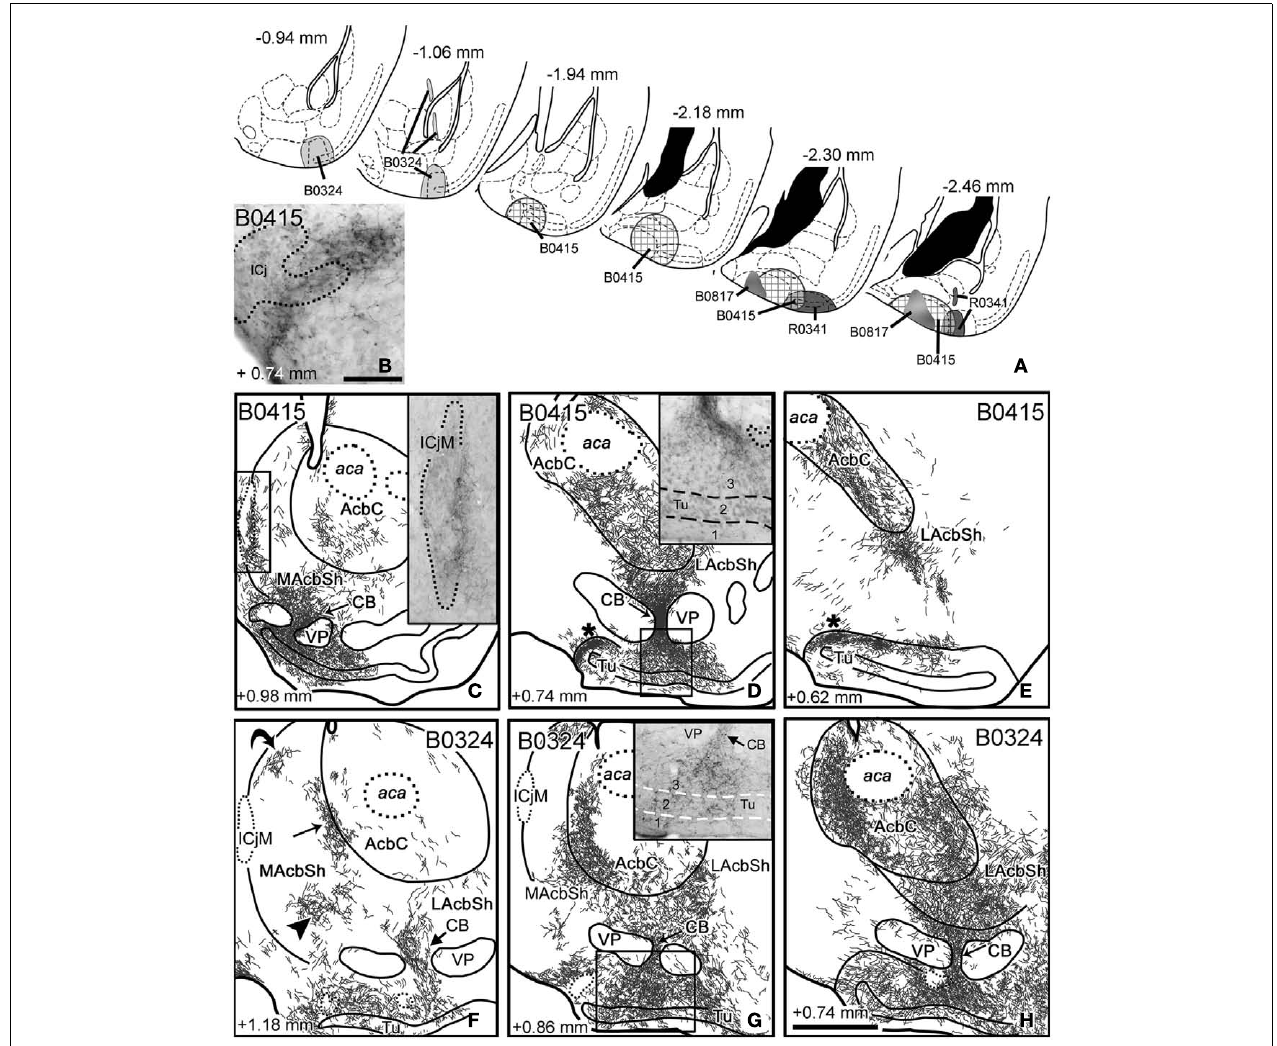
shows the meshwork of labeled fibers apposed to the medial aspect of the ICjM. Labeling in the CB extends into layer 3 of theTu [inset in (D) ]. (F–H) Schematic drawings of frontal sections through the ventral striatum of a mouse that received an injection of BDA in the CxA (B0324), showing the resulting anterograde labeling.Three arrows in (F) point to the three main terminal fields in the MacbSh, and a fourth arrow remarks the dense innervation of a cell bridge. Labeling in theTu occupies layers 2 and 3 but also invades the deepest layer 1 [inset in (G) ]. Arrows in (G,H) also point to the innervation of the striatal cell bridges. For abbreviations, see list. Calibration bar in (B) = 50 μ m. Scale bar in (H) = 400 μ m [also valid for (C–G)